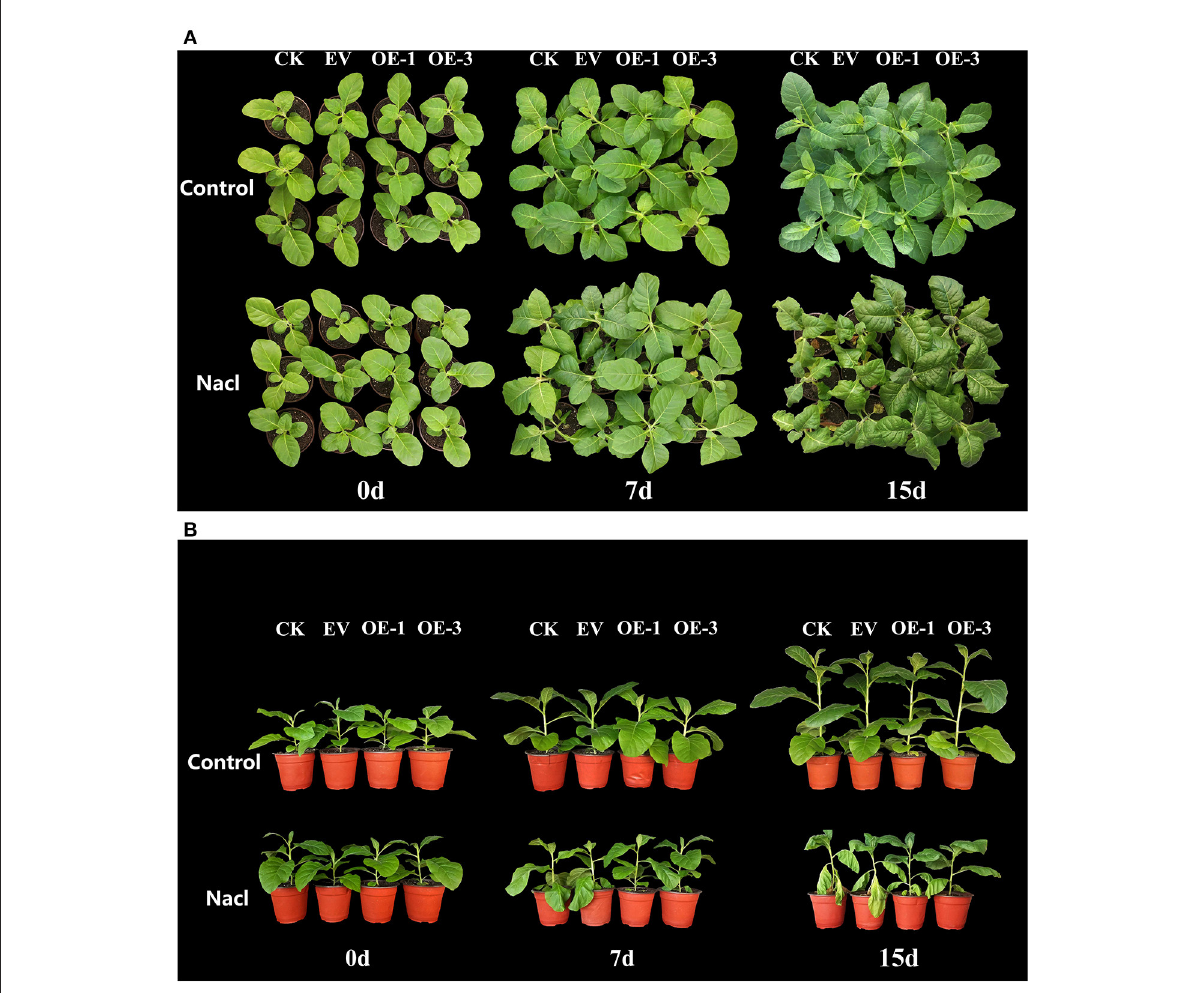
FIGURE4 Analysis of salt tolerance in the transgenic tobacco lines overexpressing LpNAC17 . (A) Comparative top view images. (B) Comparative side view